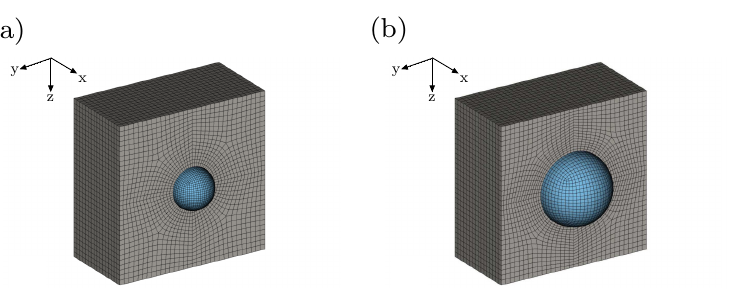
Figure 7. Finite element mesh of one half of the soft matrix and the whole spherical inclusion with a volume fraction ( a ) f = 1% and ( b ) f =